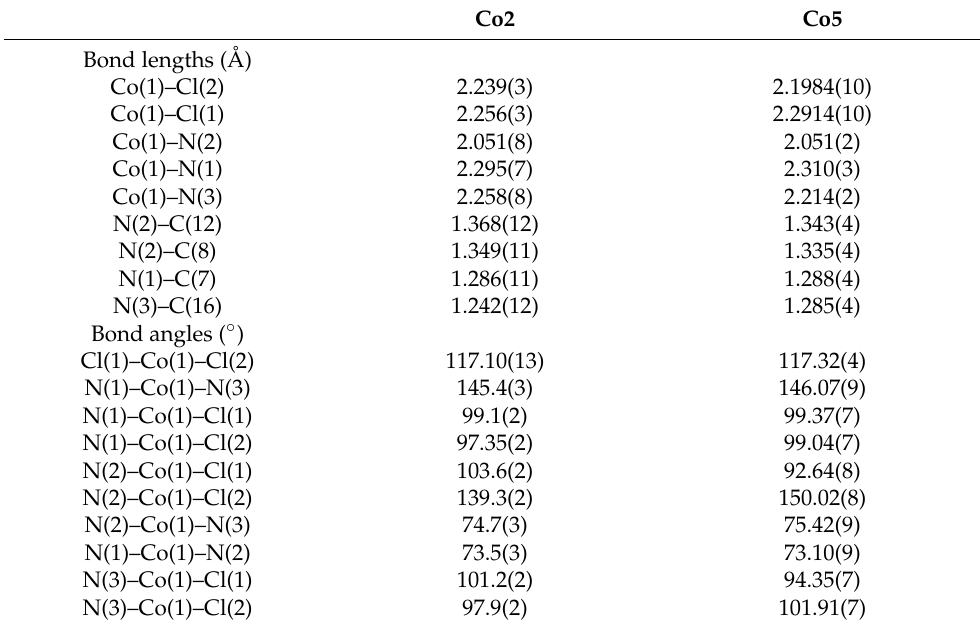
Table 1. Selected bond lengths (Å) and angles ( ◦ ) for Co2 and Co5 .